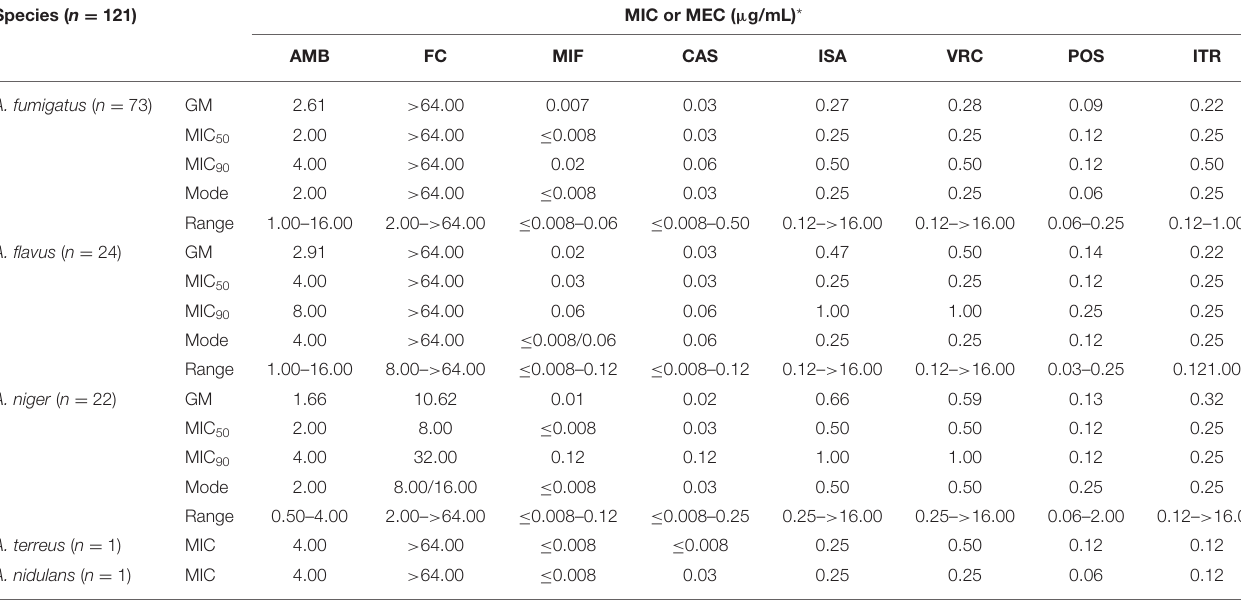
TABLE 2 | Antifungal susceptibility patterns and characteristics in the five common Aspergillus species. Species ( n =